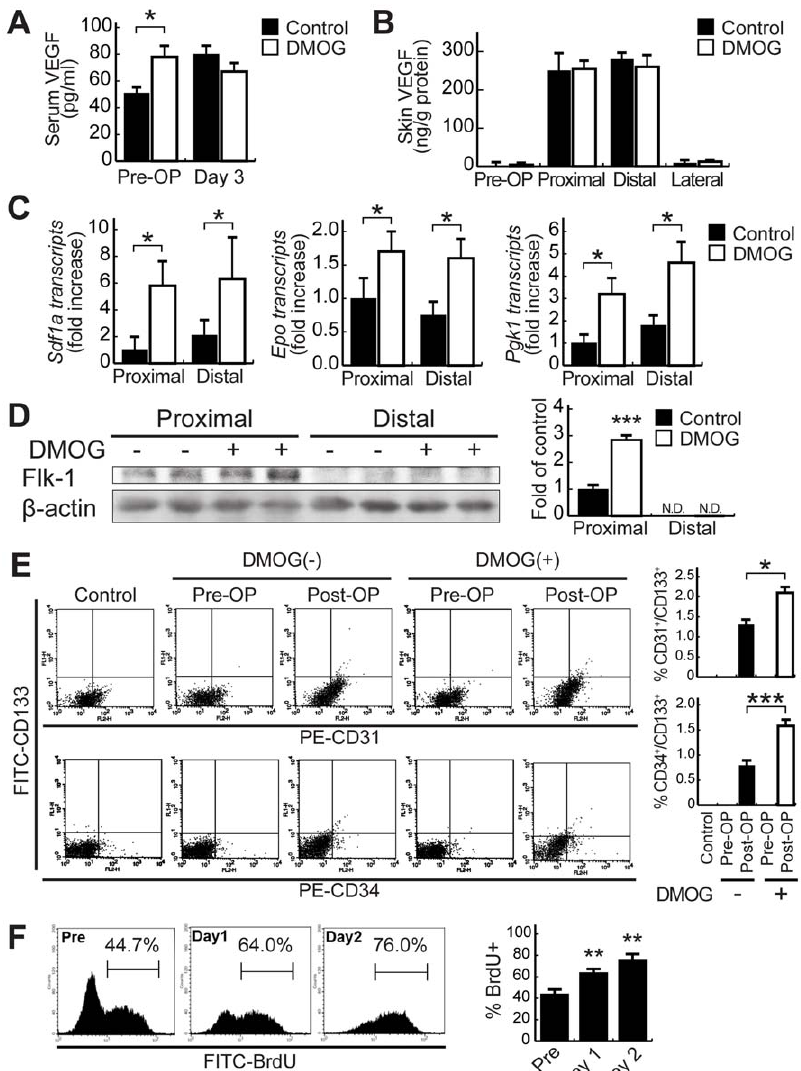
Figure 4. Effects of DMOG pretreatment on angiogenesis-related factors in the mouse skin flap model. A, Serum VEGF concentrations before and after surgery on DMOG-treated or untreated mice were measured by ELISA. Pre-OP and Day 3 indicate pre-surgery and on day 3 after the surgery, respectively. B, VEGF proteins in the skin tissues before and after surgery were measured by ELISA. Skin tissues from the proximal, distal, and lateral parts of the skin flaps were prepared for the assay. C and D, Transcript levels of HIF-1 target genes (C) and the expression of FLK-1 proteins (D) in the proximal and distal parts of the skin flaps on postoperative day 1 were assessed by quantitative RT-PCR and Western blot analysis, respectively. N.D. indicates not detectable. Values are means 6 SDM. * P , 0.05.E, Left panel, the representative flow cytometric profiles of peripheral blood cells from DMOG-treated or untreated mice. Peripheral blood cells were stained with anti-CD133, anti-CD45, anti-CD34, and anti-CD31 antibodies and analyzed with a flow cytometer. Pre-OP and Post-OP indicate before the flap operation and 1 day after the flap operation, respectively. Data were representative of at least 4 independent experiments. Right panel, summary of the ratio of the EPCs (gated on CD45-positive cells) in peripheral blood cells. F, Cell proliferation in bone marrow cells (gated on CD45-positive and CD34-positive cells) from untreated or DMOG-treated mice 1 and 2 days after the treatment was monitored by BrdU incorporation and analyzed by flow cytometry. * P , 0.05, *** P , 0.001. doi:10.1371/journal.pone.0042964.g004 treatment. We hypothesized that systemic administration of early responding and specific EPCs to the skin flap operation. We DMOG may increase proliferation of angiogenic cells in the bone detected these EPCs gated with CD45-positive cells to eliminate marrow, resulting in elevated levels of circulating EPCs in the late EPC population and CD31-positive cells to contain more early postoperative phase. We therefore investigated cell prolifer- specific EPC population [17,18]. The percentages of EPCs in the ation in the bone marrow of DMOG-treated and untreated mice peripheral blood were significantly greater in the DMOG-treated using 5-bromo-2 9 -bromodeoxyuridine (BrdU)-incorporation as- group than in the control group (1.28 6 0.17 vs. 2.2 6 0.2% says and flow cytometry. Bone marrow cells were isolated 1 hour CD45 + CD133 + CD31 + cells, P , 0.005; 0.74 6 0.03 after intraperitoneal injection of BrdU. The percentage of BrdU- positive cells in the CD45 + CD34 + hematopoietic progenitor cell on post-operative day 1, whereas these cells were barely detectable population, which should include the EPCs, was measured. As immediately prior to the surgery, 48 hr after the single DMOG